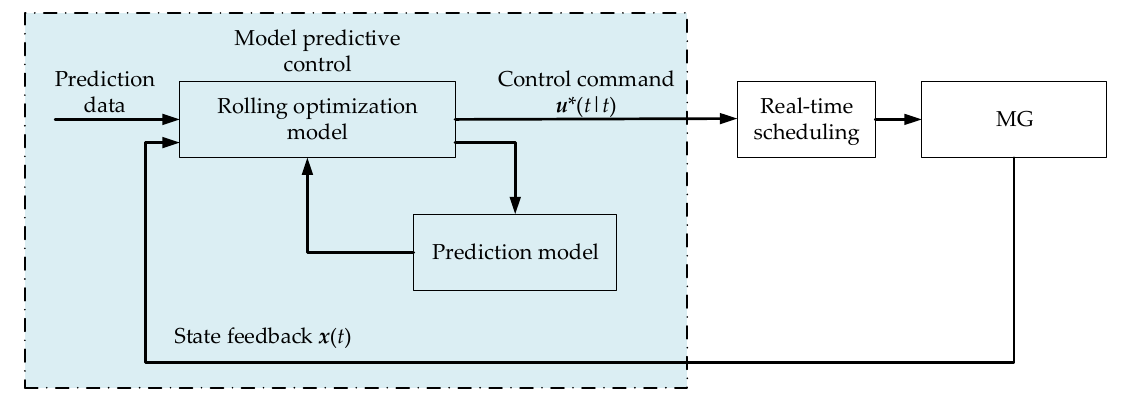
Figure 3. MPC based rolling scheduling optimization framework.